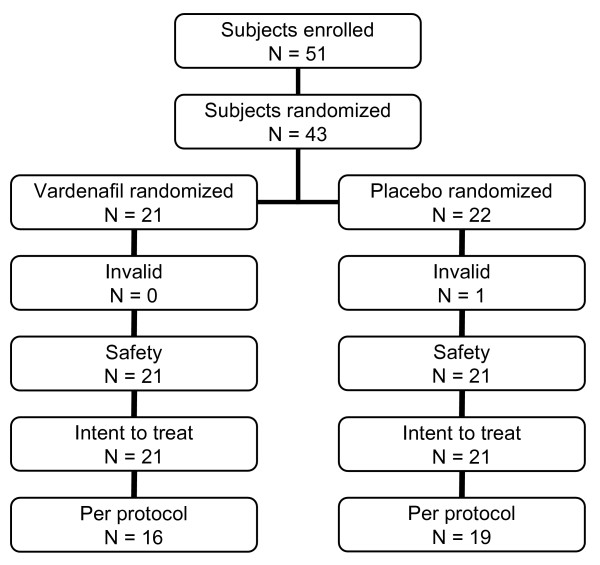
Flow chart of study population.